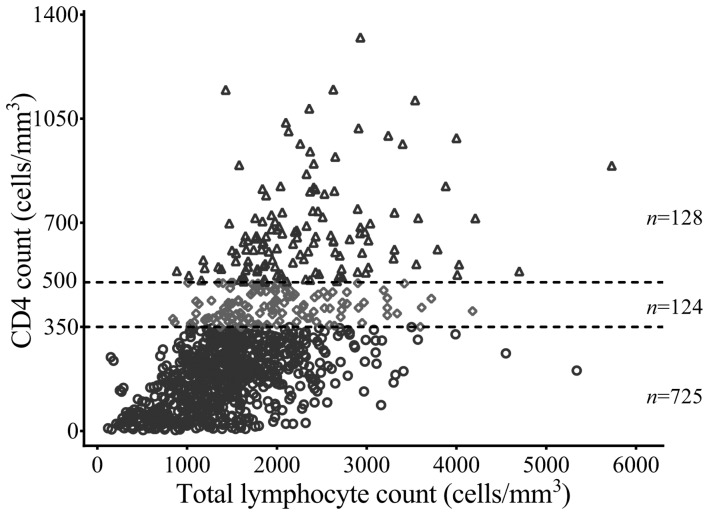
Scatter plot for 977 pairs of total lymphocyte count (TLC) and CD4 cell count.The lower circle dots are for 725 pairs of TLC (median [interquartile], 1370 [1025–1760] cells/mm3) and CD4 cell count of less than 350 cells/mm3. The middle diamond dots are for 124 pairs of TLC (median [interquartile], 1885 [1500–2355] cells/mm3) and CD4 cell count of between 350 cells/mm3 and 500 cells/mm3. The upper triangle dots are for 128 pairs of TLC (median [interquartile], 2222 [1840–2698] cells/mm3) and CD4 cell count of greater than 500 cells/mm3.